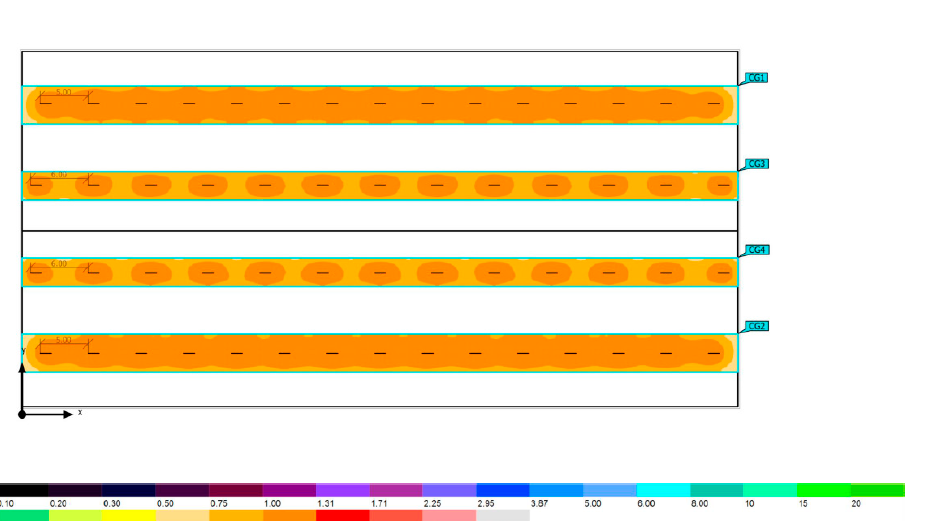
Figure 5. Modeled calculated distribution of illumination inside the cowshed using 56 LED lamps. Figure 6. Calculated illumination values in the program applied in the cowshed depending on the height of the considered surface.